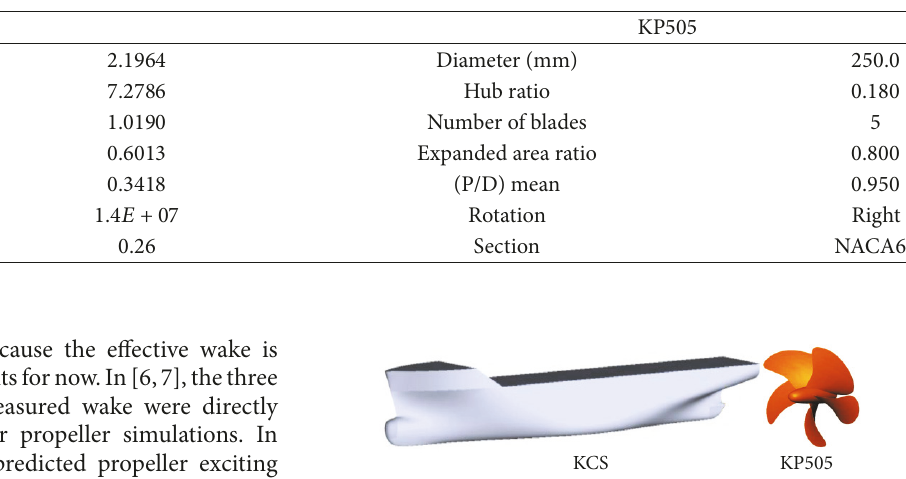
Table 1: Principal particulars of the model-sized hull and propeller.